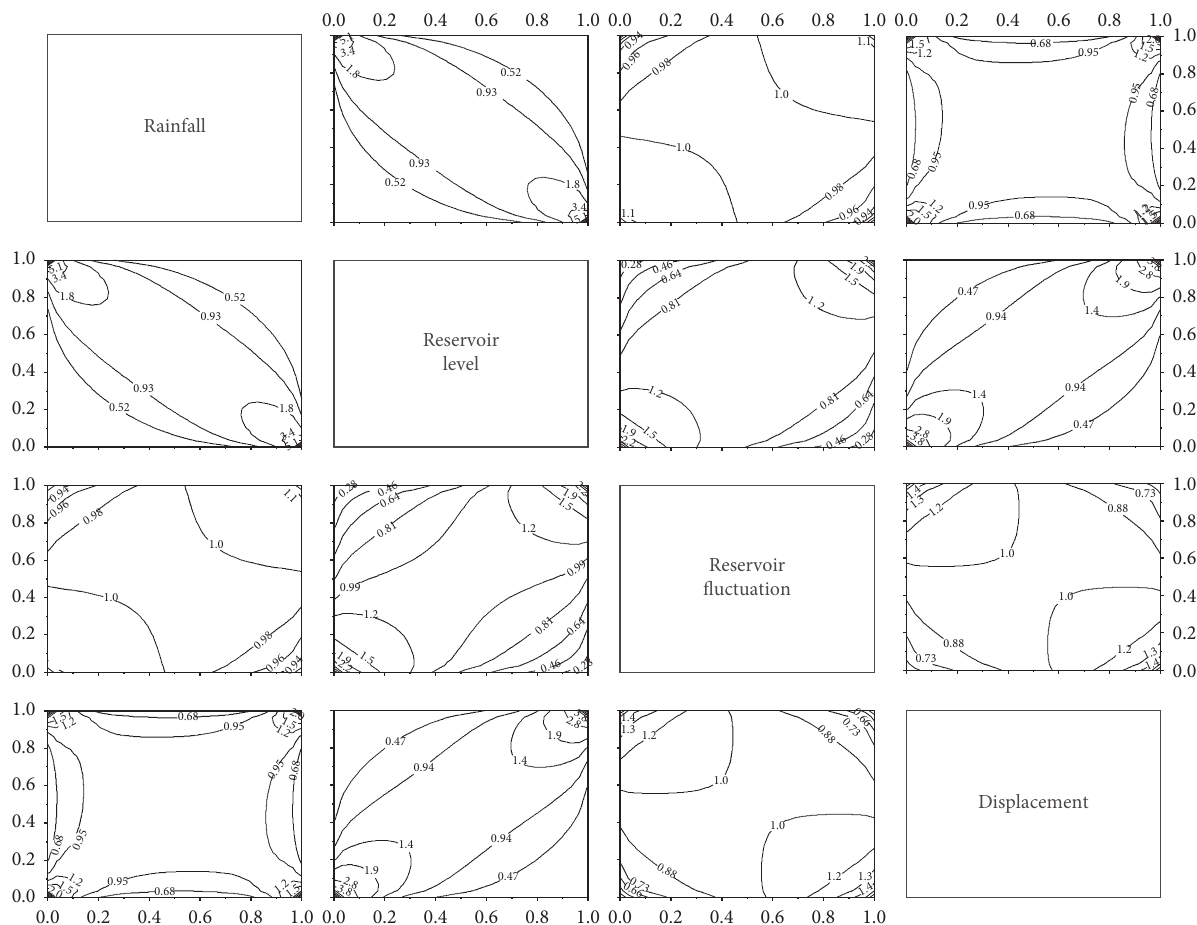
Figure 7: Cross sections of joint t-copula density between rainfall, reservoir level, reservoir fluctuation, and landslide level. The above results indicate that weak to strong cor- relations were found between the selected optional input variables and output displacement, and thus, the seven optional inputs were adopted in the following process.